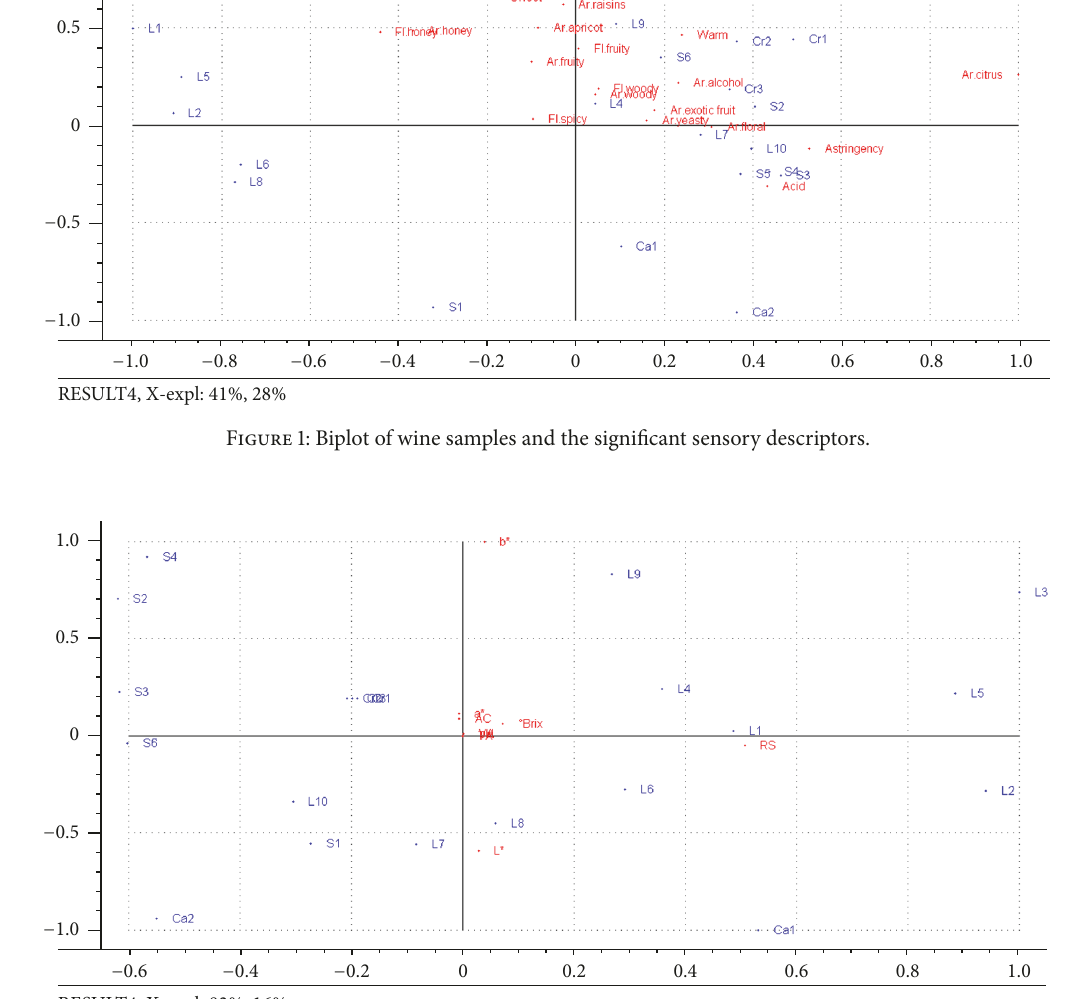
Figure 2: Biplot of wine samples and the physicochemical